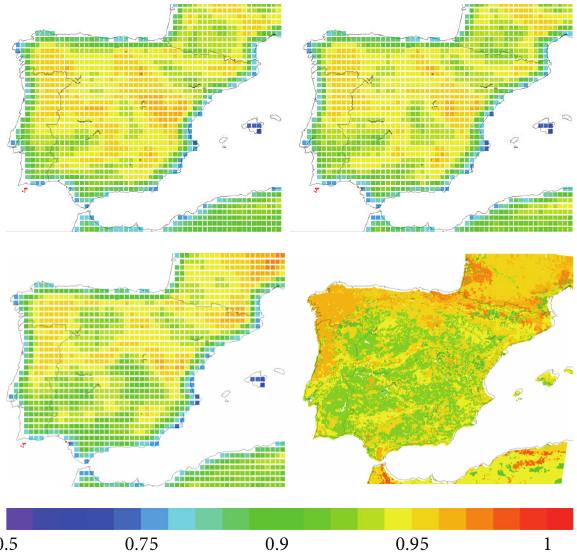
Figure 4: Examples of emissivity values (all images refer to 89 GHz- V)usedforSDSUsimulations.Topleft:TELSEMFebruary,topright: TELSEM march, bottom left: TELSEM December, and bottom right: proposed method’s